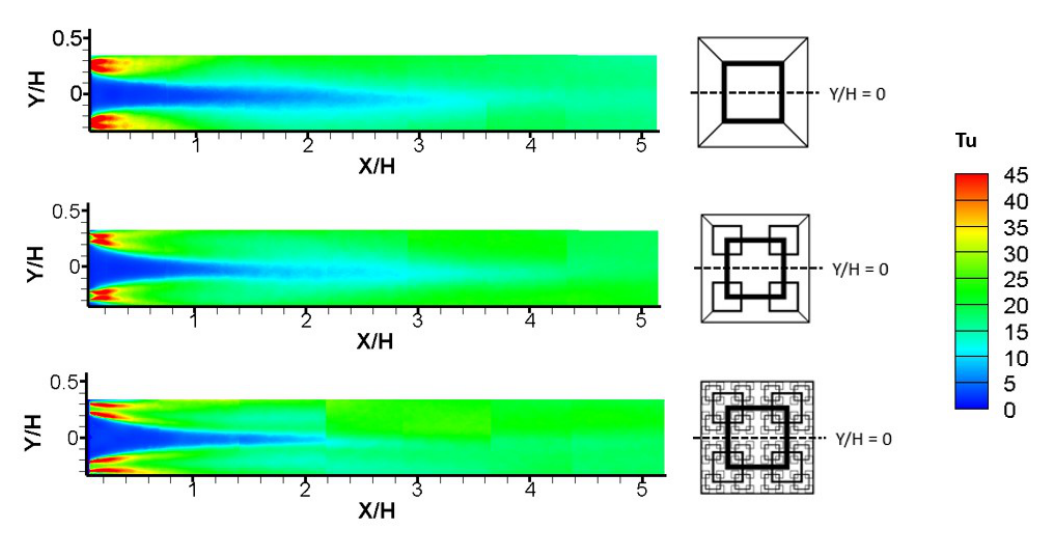
Figure 7. Streamwise turbulence intensity T u (%) downstream of a fractal square grid at Re = 3400. FG1, FG2 and FG4 from top to